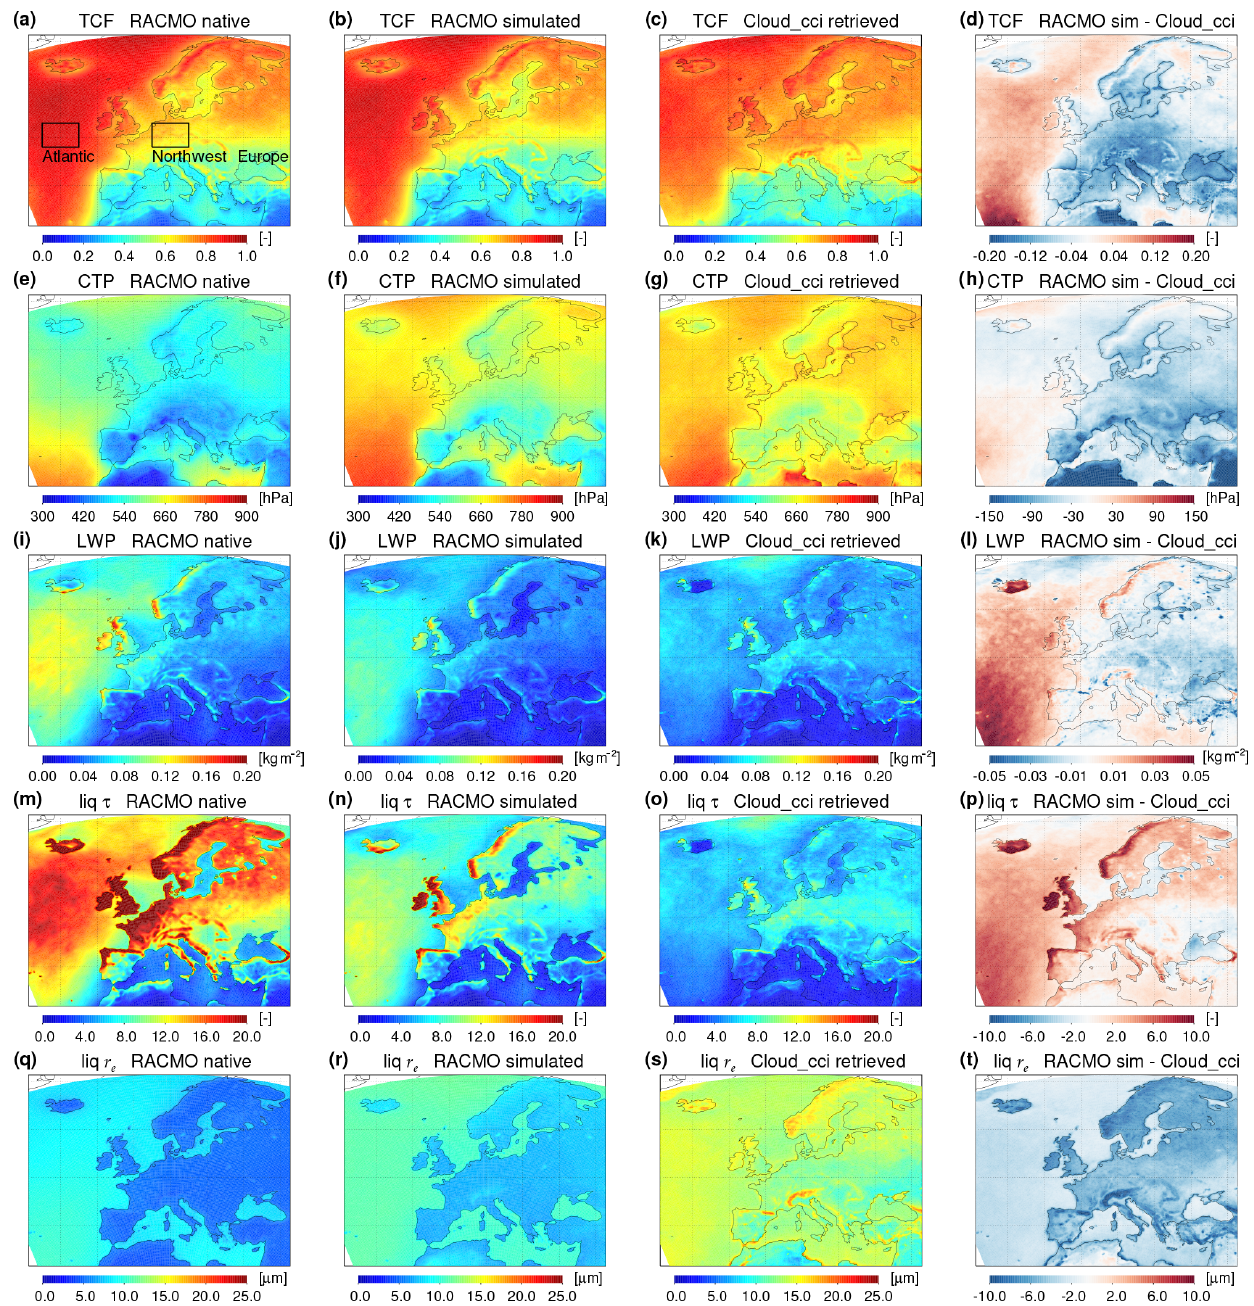
Figure 11. Maps of 2011–2014 mean modeled and retrieved cloud properties: (a–d) total cloud fraction, (e–h) cloud top pressure (hPa), (i–l) LWP (kgm − 2 ), (m–p) liquid τ c , and (q–t) liquid r e (µm). The columns show from left to right the native model, the simulator, the Cloud_cci data, and the difference between simulator and retrieval. All properties are all-sky averages, except CTP and r e , which are in- cloud averages. In addition, CTP has been logarithmically averaged, while the other properties have been linearly averaged. Panel (a) shows the areas defined for the time series analysis in Fig.